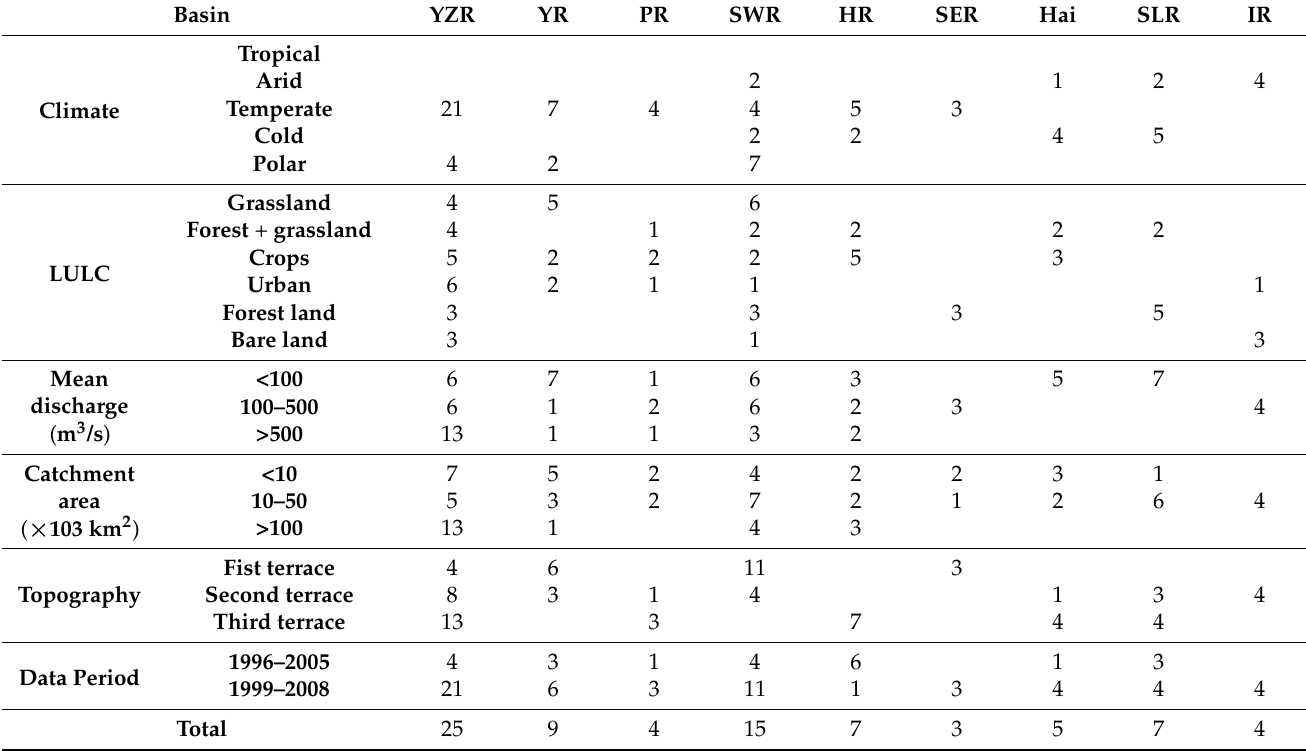
Table 1. Statistics of climate, land use/cover (LULC), topography and data period of 79 stations for the 9 basins, which are Yangtze River Basin (YZR), the Yellow River Basin (YR), the Pearl River Basin (PR), the Southwest River Basin (SWR), the Huai River Basin (HR), the Southeast River Basin (SER), the Hai River Basin (Hai), the Songliao River Basin (SLR) and the Inland River Basin